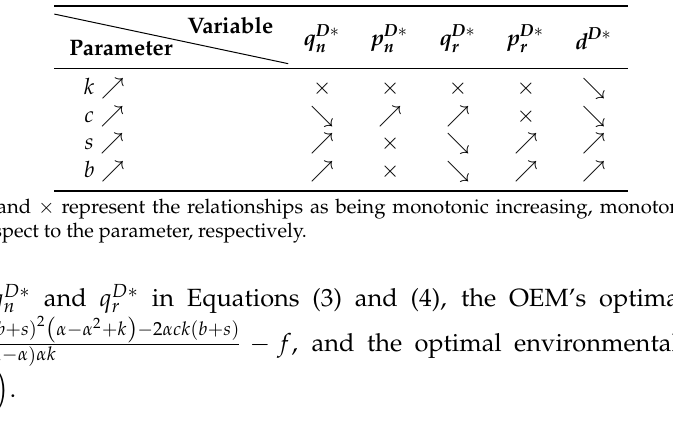
Table 3. Influence of Various Parameters under Policy D on the OEM’s Output and Pricing Decisions.